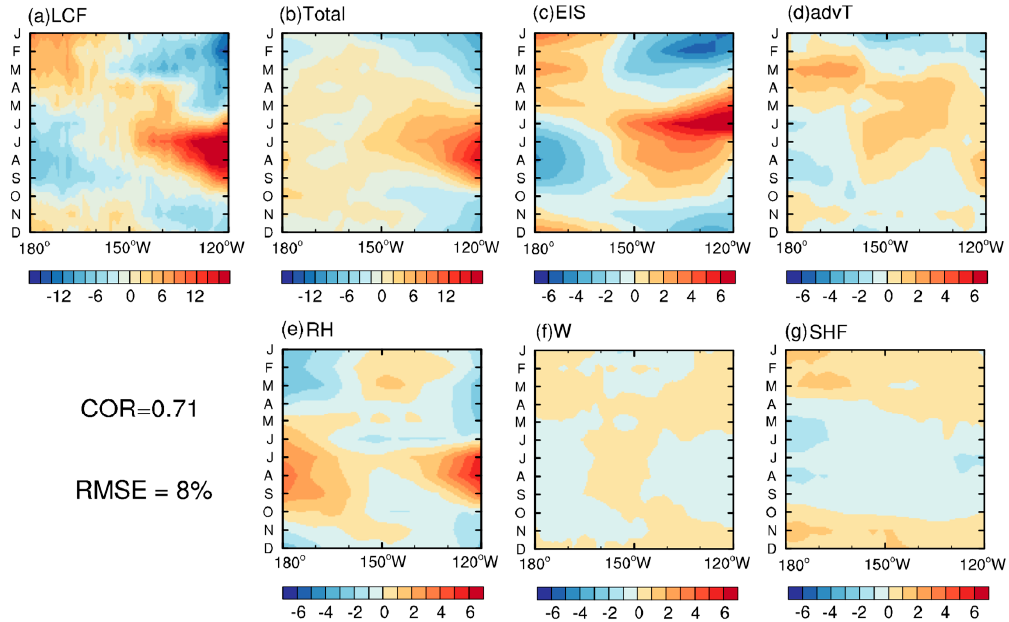
Figure 4. ( a ) Same as Figure 2a, except that the annual-mean LCF (%) has been removed. ( b ) Same as ( a ), except for the corresponding LCF (%) predicted by the multiple linear regression model. The correlation and root mean square error (RMSE) between ( a , b ) are shown below ( a ). ( c – g ) Same as ( b ), except for individual contributions from EIS, advT, 700-hPa RH, 700-hPa subsidence, and SHF to ( b ), respectively. Atmosphere 2019 , 10 , x FOR PEER REVIEW